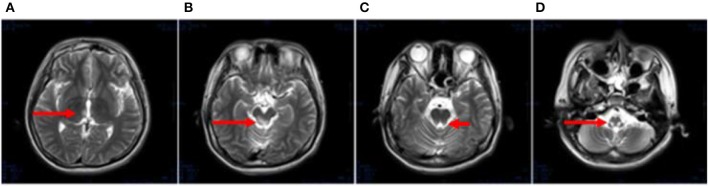
(A–D) Axial, T2-weighted MRI at 1 month following hospitalization revealed high signal intensity in the lateral ventricle, periaqueductal gray matter (bilateral hypothalamus and midbrain tegmentum, arrow in A,B), and medullary tegmentum (arrow in D). There were no evident lesions in the tegmentum of pons at this stage (small arrow in C).